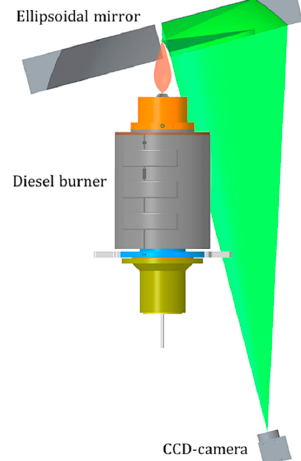
Figure 4. Rotatable camera-mirror system. Camera, mirror, and optical set-up are tilted by 15° with respect to the vertical axis of the burner. In this way the signal collected by half of the mirror is imaged into the camera without being blocked by the burner itself.